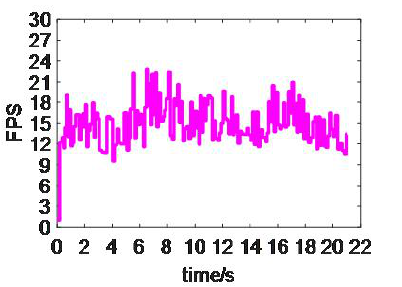
Figure 18. Distance measured by the follower robot’s vision system.